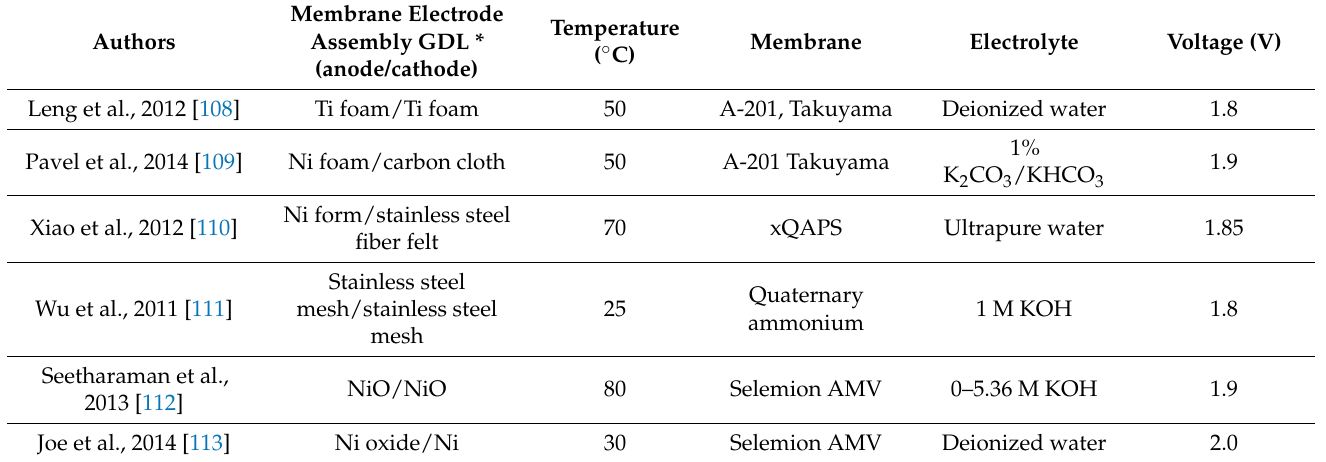
Table 2. Summary of the AEM electrolysis system for hydrogen